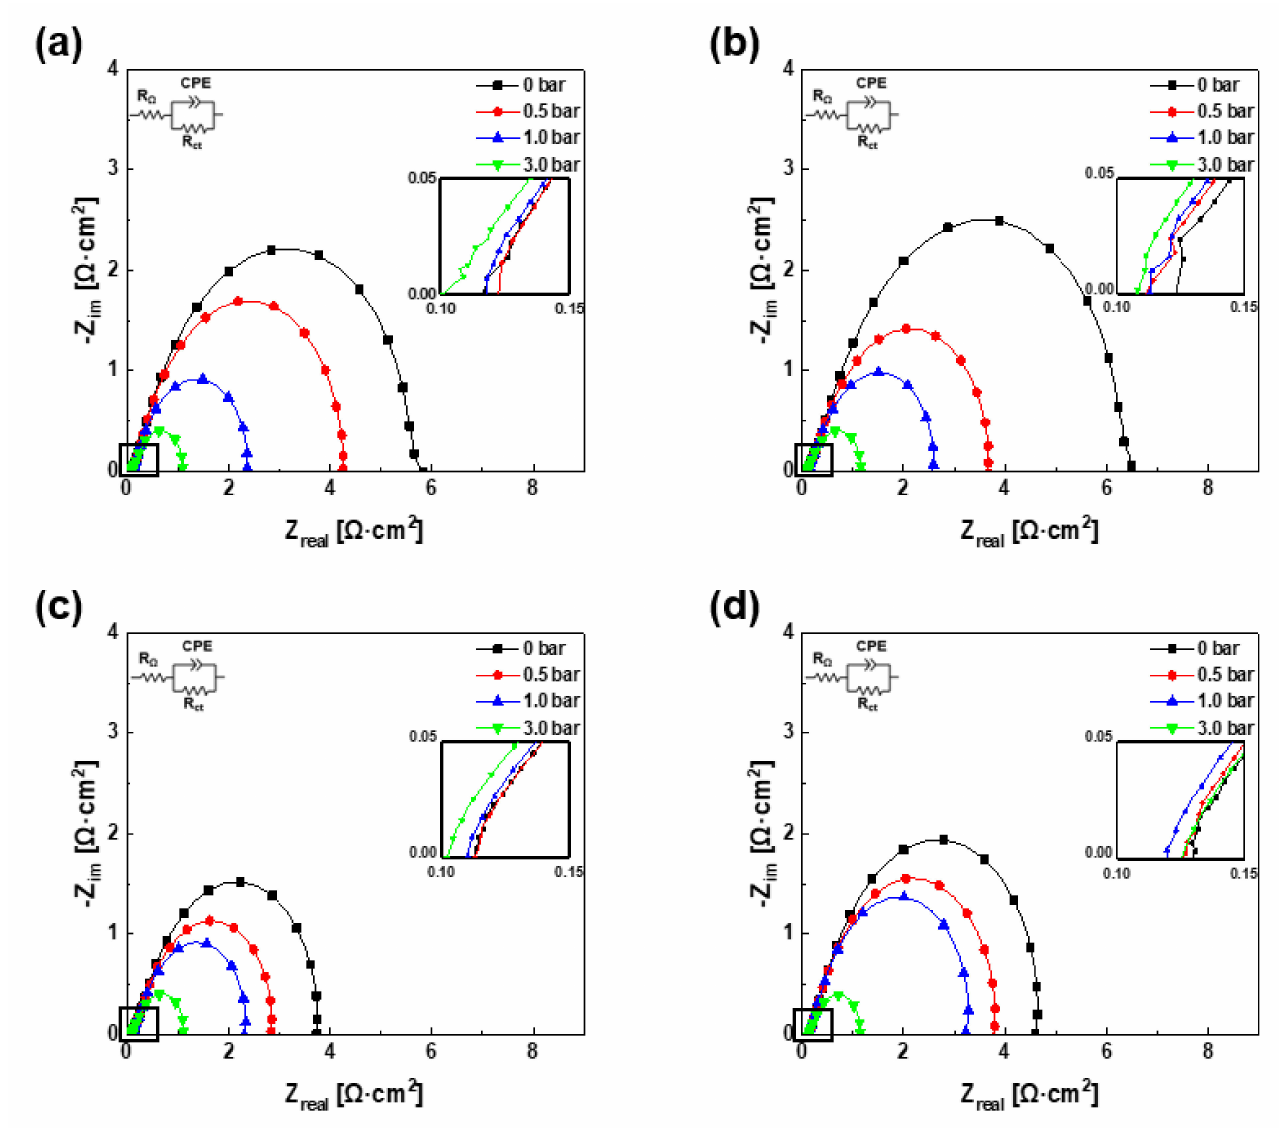
Figure 5. EIS measurements at 0.85 V (vs. RHE) of the PEMFCs with ( a ) A1C1, ( b ) A3C1, ( c ) A1C3, and ( d )